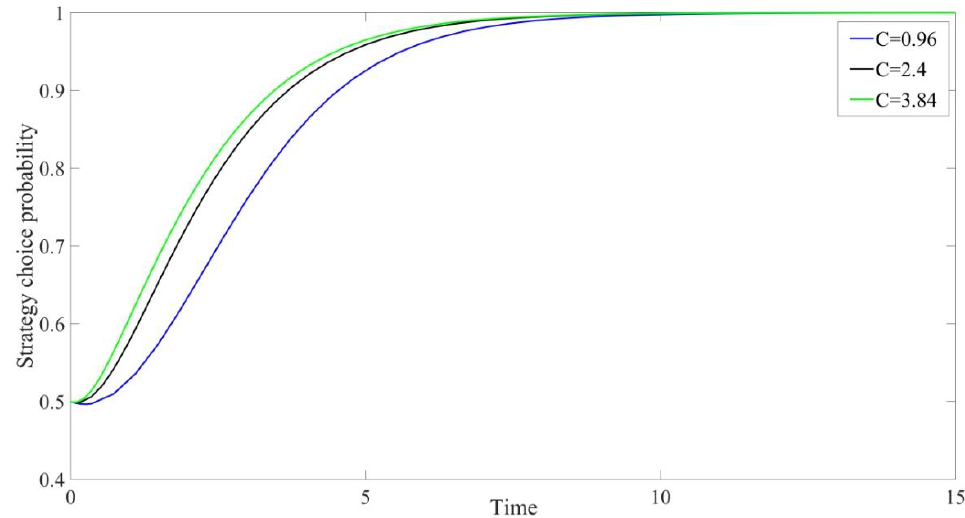
Figure 12. Simulation of different investments in cross-border e-commerce infrastructure. (4)